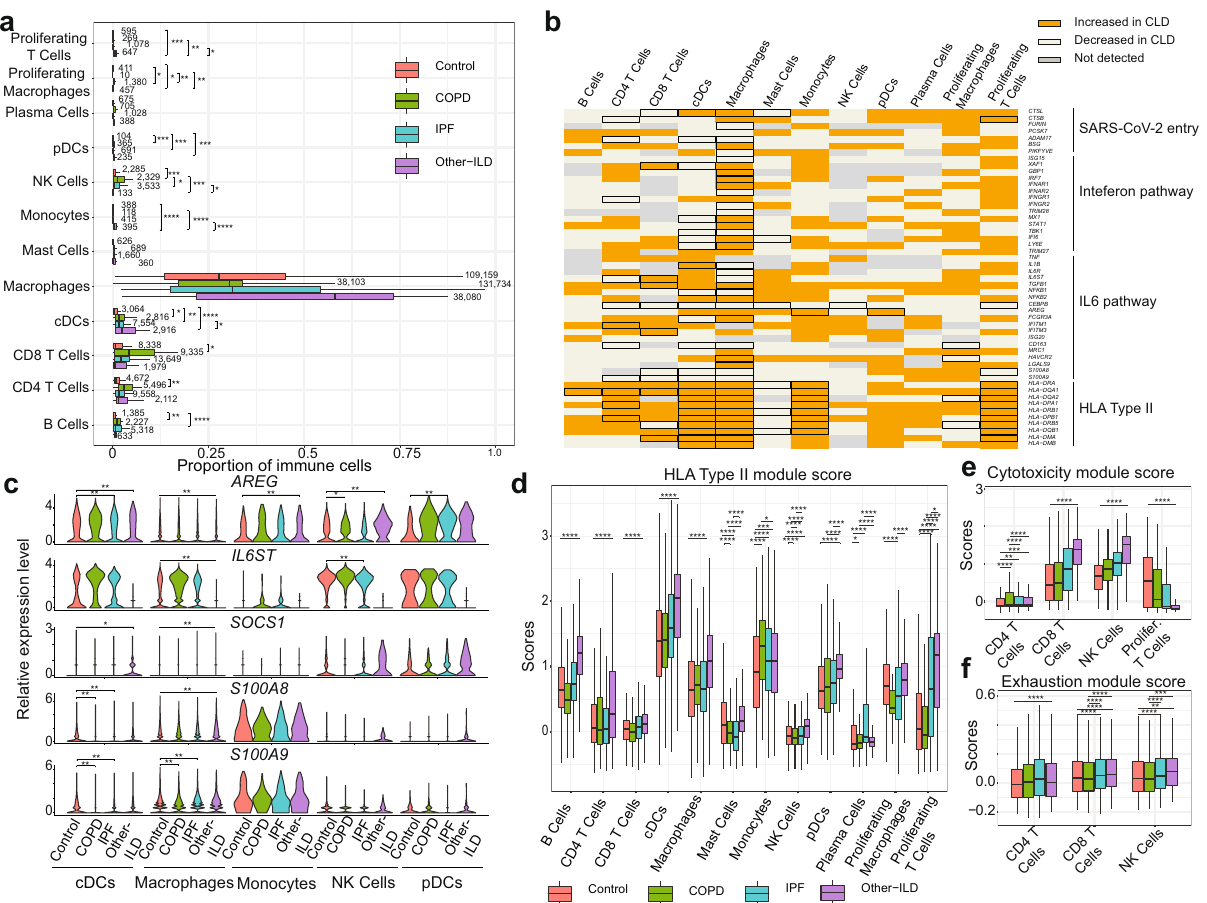
Fig. 4 Analysis of SARS-CoV-2 candidate immune response genes in immune cells. a Quanti fi cation of cell types as a percent of all immune cells in control and diseased lungs, numbers represent the total numbers of the cell type per individual samples, data are presented as mean values± SEM. b Binary heatmap representing a manually curated list of genes associated with SARS-CoV-2. Orange elements indicate genes with increased expression and white elements indicate genes with decreased expression; Not detected: gene expression was not detected in either of the two tested populations (CLD vs. Control); DEGs with FDR ≤ 0.1 are outlined in black. c Differential expression analysis for SARS-CoV-2 immune candidate genes in cDCs, Macrophages and Monocytes. * p -adjusted value < 0.1, ** p -adjusted value < 0.05, p -adjusted value was Bonferroni adjusted from Seurat FindMarkers differential expression analysis using a negative binomial test and corrected for Age, Ethnicity, Smoking_status and Dataset. d Compared to the healthy control samples, HLA type II score is higher in all disease groups (especially Other-ILD). In the T cell population, cytotoxicity scores ( e ) and exhaustion scor e s ( f ) are higher in the disease samples than in control samples. In a , d , e , and f : Boxes: interquartile range, lower and upper hinges correspond to the fi rst and third quantiles, upper and lower whisker extends from the hinge to the largest values or smallest values of 1.5 x interquartile range; Tukey_HSD post-hoc test: * p value < 0.05, ** p value < 0.01, *** p value < 0.001, **** p value < 0.0001. See Supplementary Fig. 10 for plots with outliers included for d –